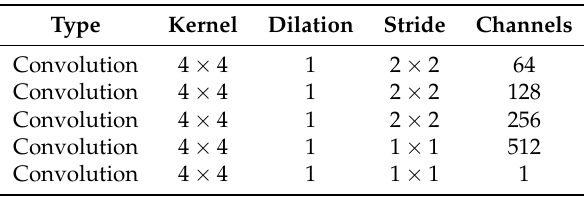
Table 2. Detailed architecture of the discriminators. The output layer produces a score map instead of a single score, so as to tell the realism of different local regions of the input images. Type Kernel Dilation Stride